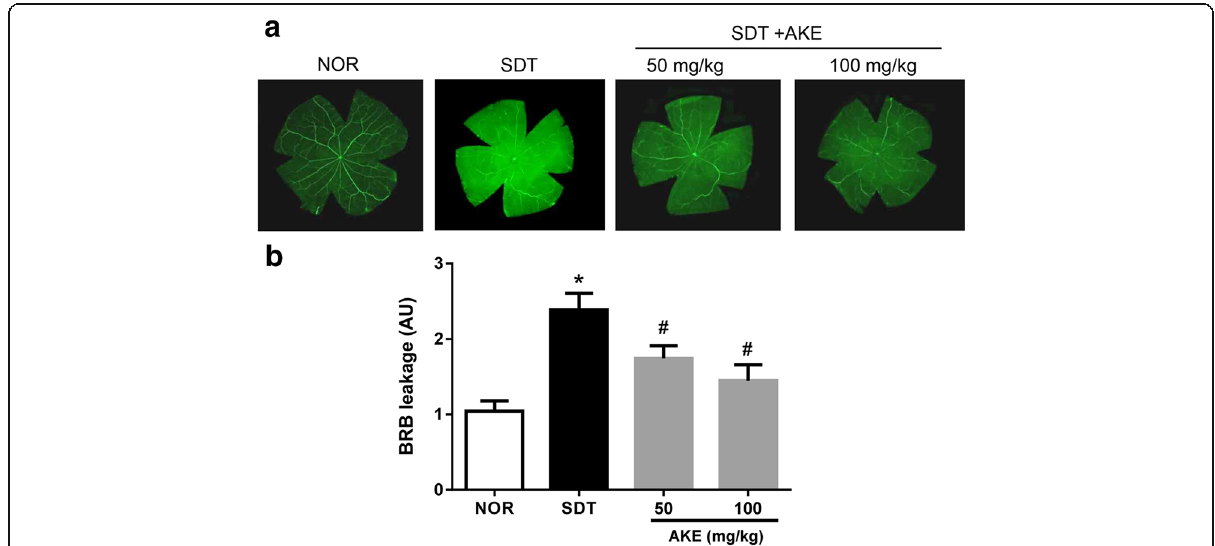
Fig. 1 Blood – retinal barrier breakdown. a FITC-dextran microscopy on retinal flat mounts. b Quantitative analysis of BRB leakage using the FITC-dextran